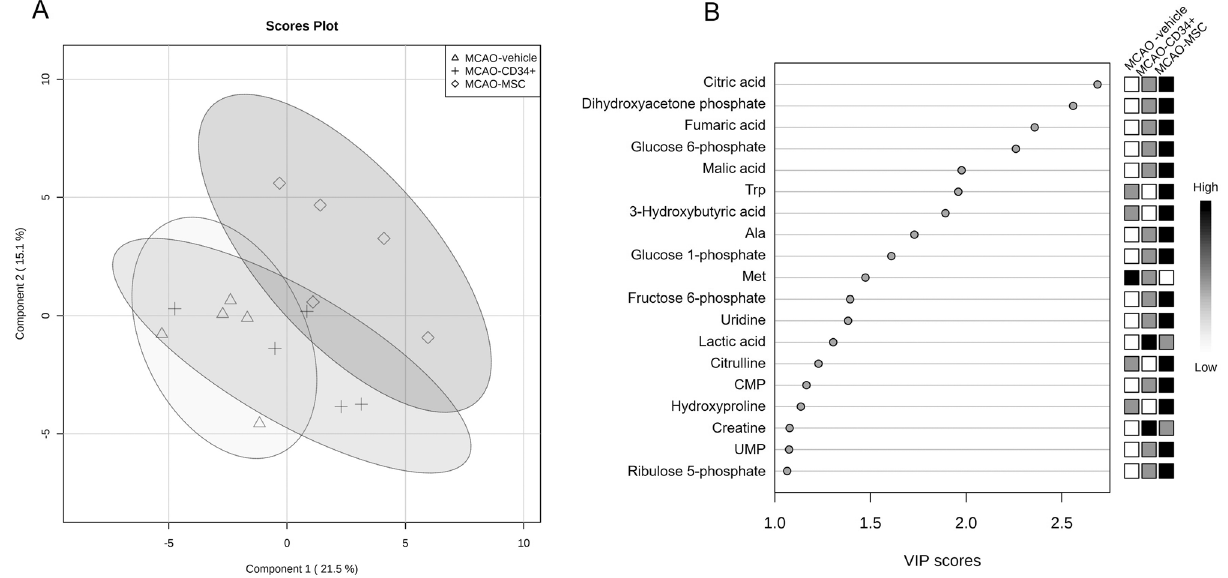
Figure 4. Multivariate analysis of cerebral metabolomic changes among the MCAO groups. Concentration data for 79 metabolites detected among the three MCAO groups were subjected to partial least-squares discriminant analysis (PLS-DA). The score plot illustrates the difference between the MCAO-vehicle group (triangle) and the MCAO-MSC group (diamond) ( A ). Variable importance in the projection (VIP) scores > 1 among the three MCAO groups were extracted and are shown in a score plot ( B